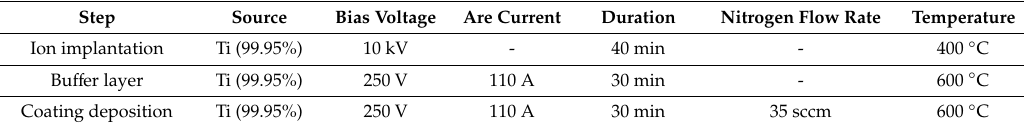
Table 2. Deposition parameters of TiN coating [30].